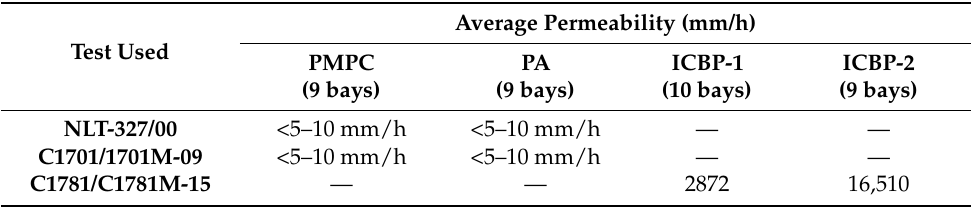
Table 5. Permeability values for each surface after 10 years of